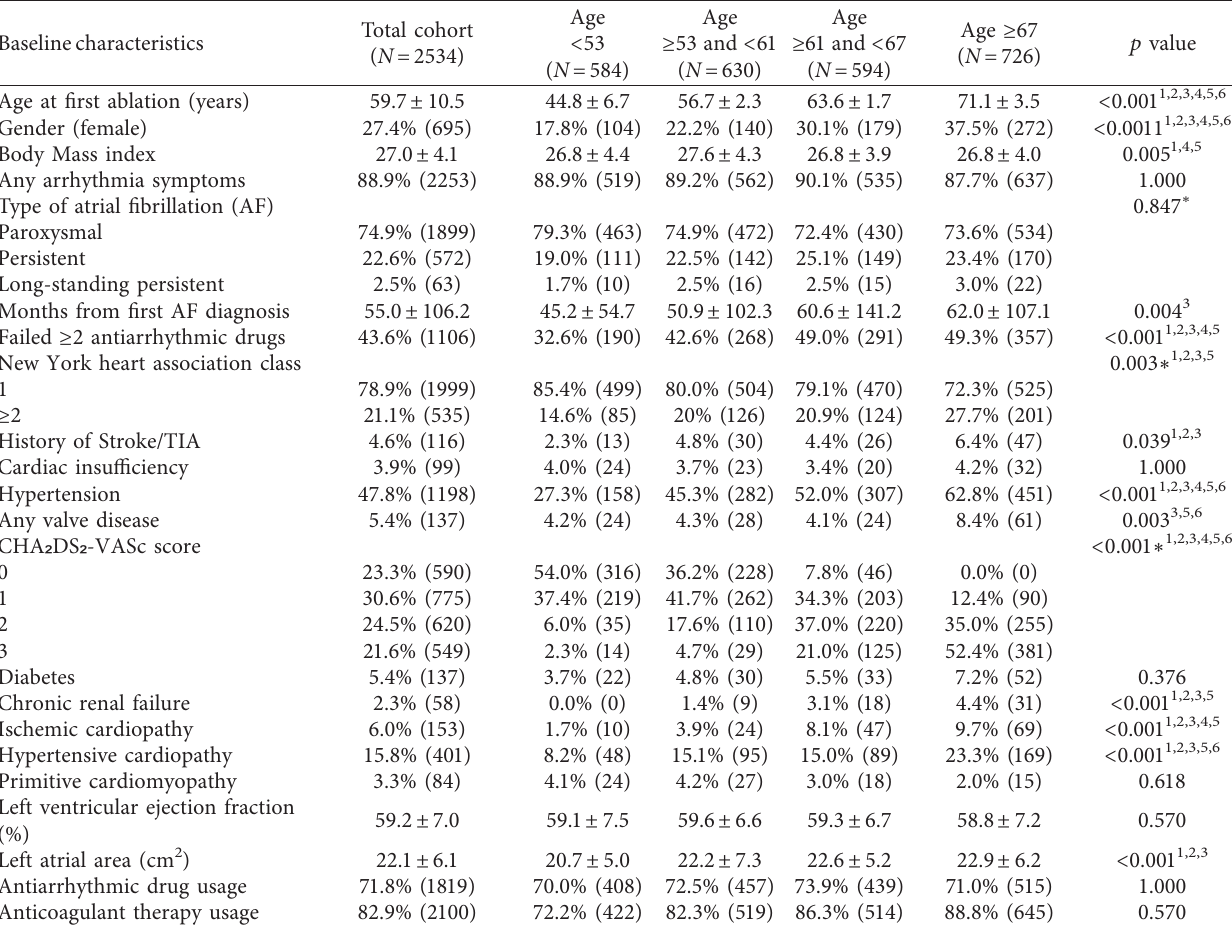
Table 1: Baseline patient characteristics ( N � 2534) by